Question: Name the type of graph shown.
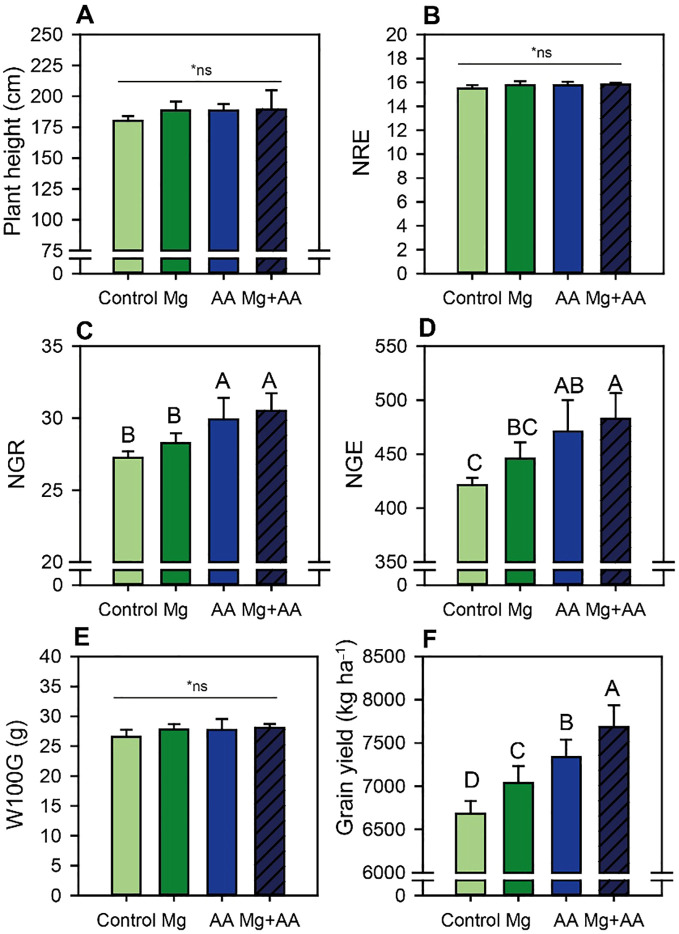
Answer: bar